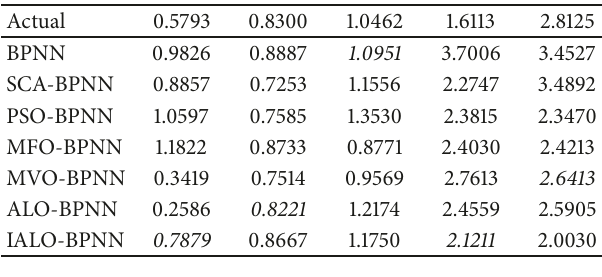
Table 4: Predicting the incidence of